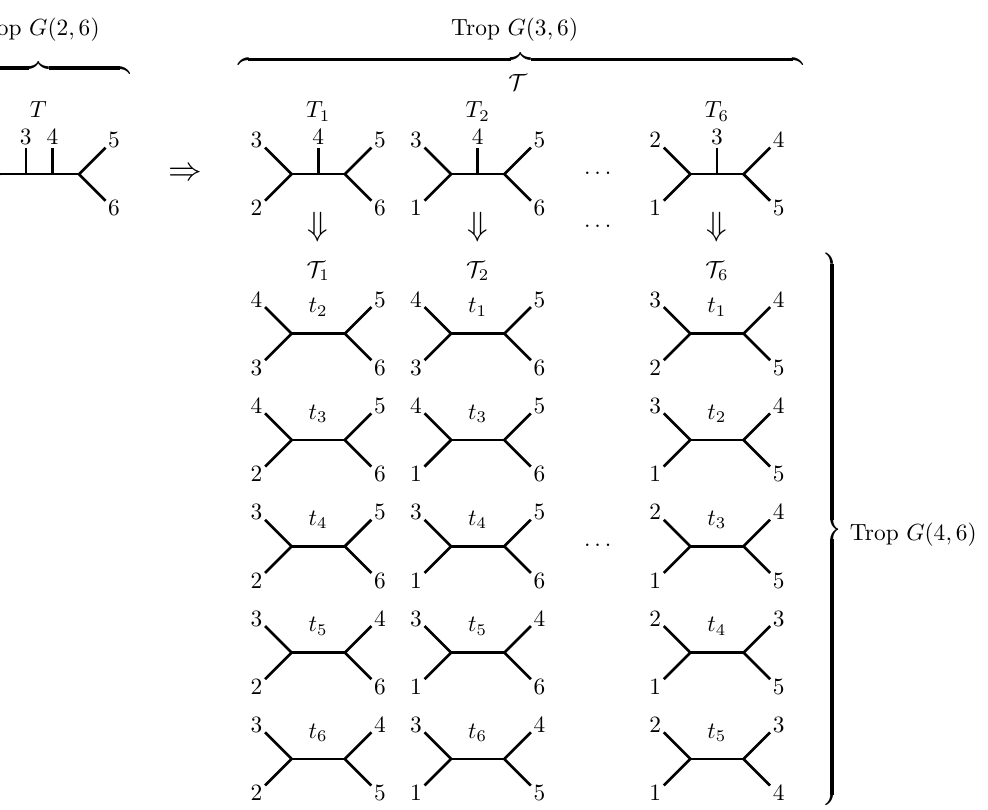
Figure 11 . As stated in section 2, one can construct a planar collection T (related to Trop G (3 , 6) ) from every tree in Trop G (2 , 6) . Now, from each such planar collection one can generate a planar collection of collections of Feynman diagrams by constructing the dual of each tree in T . This planar collection of collections should contribute to n = 6 , k = 4 amplitudes (and be related to Trop G (4 , 6) ). Since Trop G (4 , 6) ∼ Trop G (2 , 6) , this “layered collection” represents the dual object of the tree T